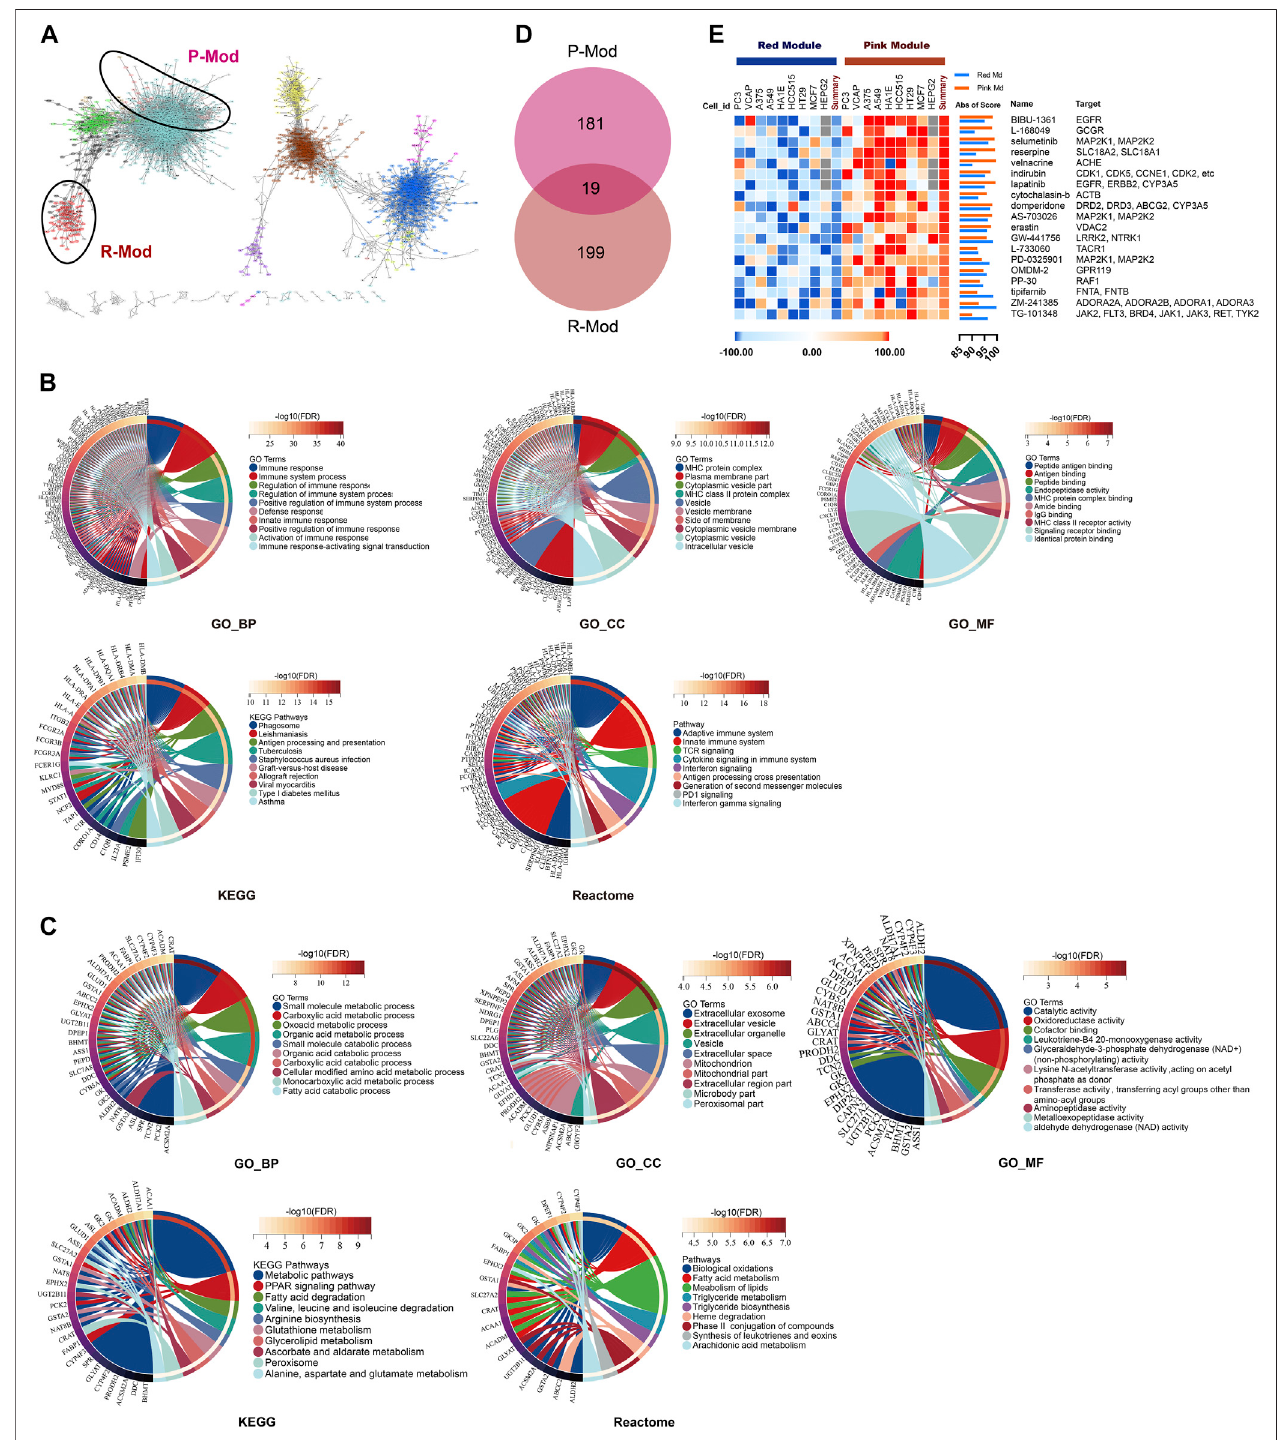
FIGURE4| PPInetwork,functionalenrichmentanalysis,andpotentialtargetedtherapeuticsbasedonSCr-relatedmodules. (A) Interactionnetworkanalysisbased on WGCNA. Each dotiscolor-codedby its corresponding module.R-/P-Mod aremarkedwith circles. (B,C) Chordplots oftheenriched GO/KEGG/Reactome terms of R- (B) /P-Mod (C) . (D) Venn plot depicts the overlap of 19 small molecular compounds identi fi ed in both red-module-targeted (Score ≥ 90) and pink-module-targeted (Score ≥ 90) compounds. (E) Heatmap of expression pattern scores of 19 targeted compounds in P- and R-Mod, respectively.